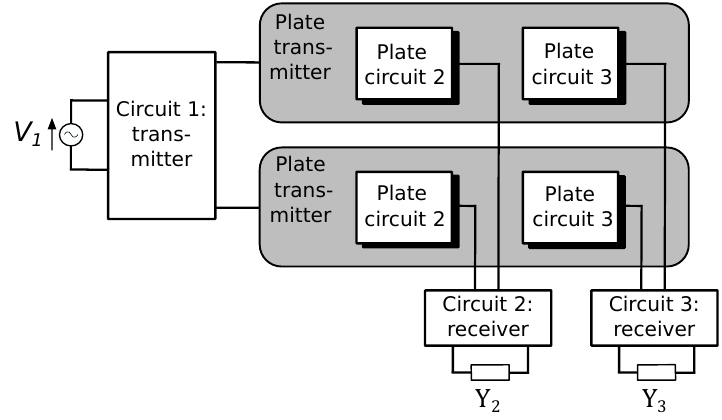
Figure 1. Schematic overview of a capacitive wireless power transfer (CWPT) system with one transmitter and two